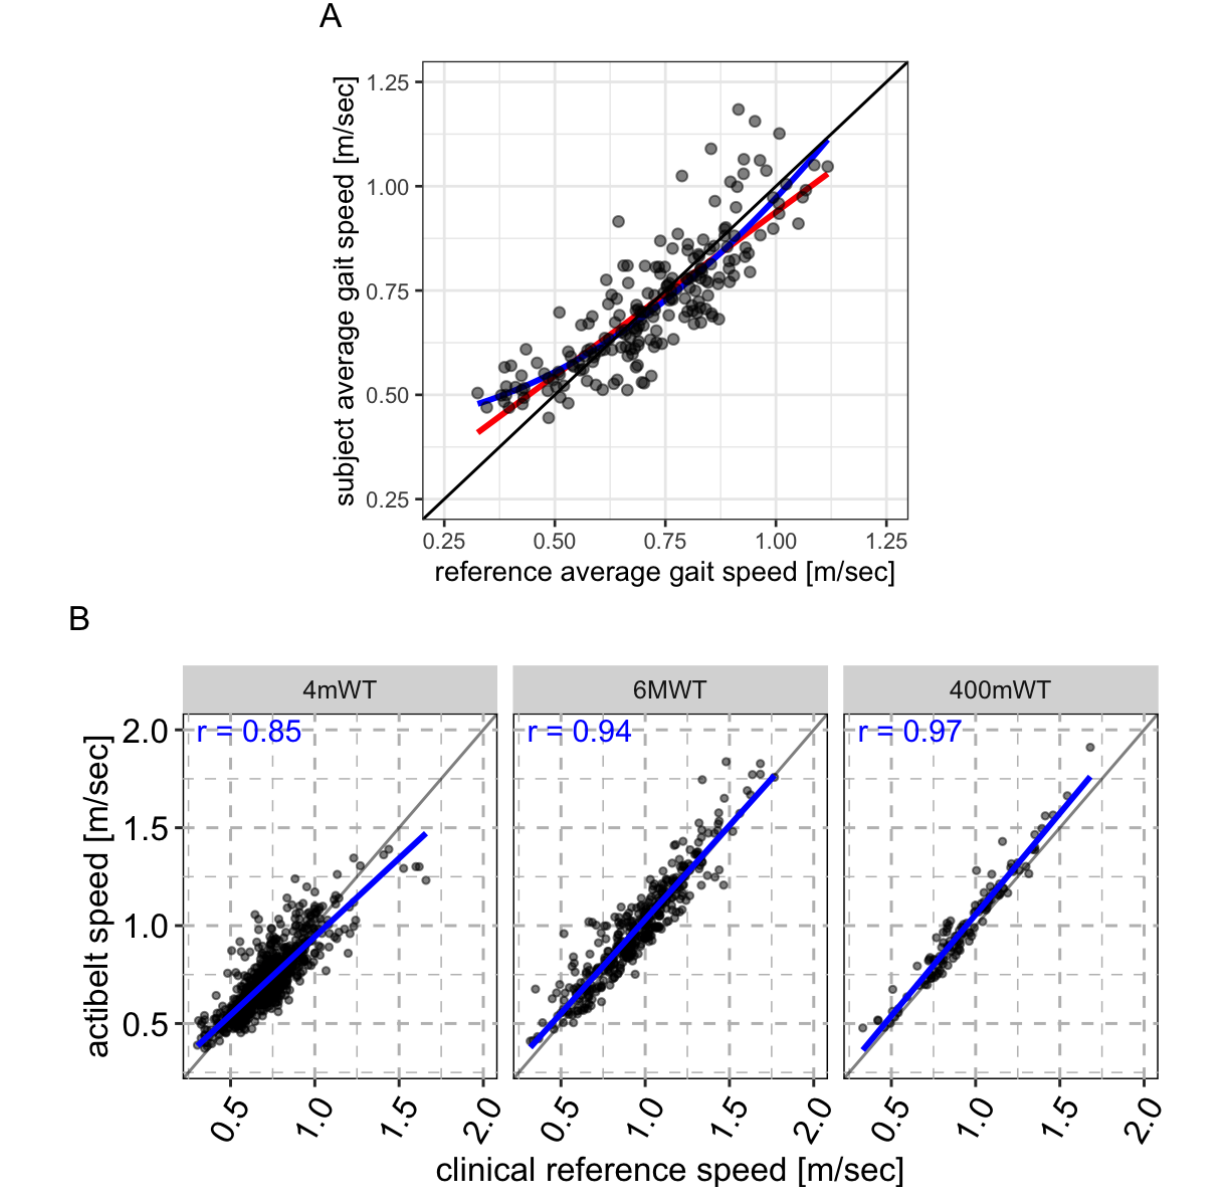
Figure 1. Accuracy of the algorithm in frail, slow walking adults. (A) Results from the independent validation study “parcours”. Reference gait speed continuously captured using an assistant-operated device is shown on the x axis, and accelerometer-derived patient gait speed is shown on the y-axis. Each datapoint represents the median speed for a given subject and parcours section. Derived gait speed is shown to strongly associate with reference gait speed in this parcours setting, the intercept for the linear fit (red line) is 0.15 and the slope is 0.78 the residual standard error is 0.08 m/sec. For comparison, a cubic fit is included (blue line). (B) Results from sarcopenic adults as captured during scheduled clinical walking test assessments in the interventional clinical trial. Reference gait speed (calculated as the distance traveled by the patient during the assessment divided by the time taken to complete the assessment) is shown on the x-axis, and accelerometer-derived gait speed is shown on the y-axis. Each datapoint represents the average speed for a given patient and assessment. The intercept for the linear fit is 0.15, 0.09, 0.09 from left to right and the slope is 0.79, 0.95 and 0.96, the residual standard error is 0.08, 0.09 and 0.07 m/sec for the 4mWT, 6MWT and 400mWT (panels, left to right), respectively. Note, the 400 meter walk test was collected for relatively few patients. A strong linear association is observed between derived and reference gait speed in all assessments indicating accuracy in our target population of frail, slow